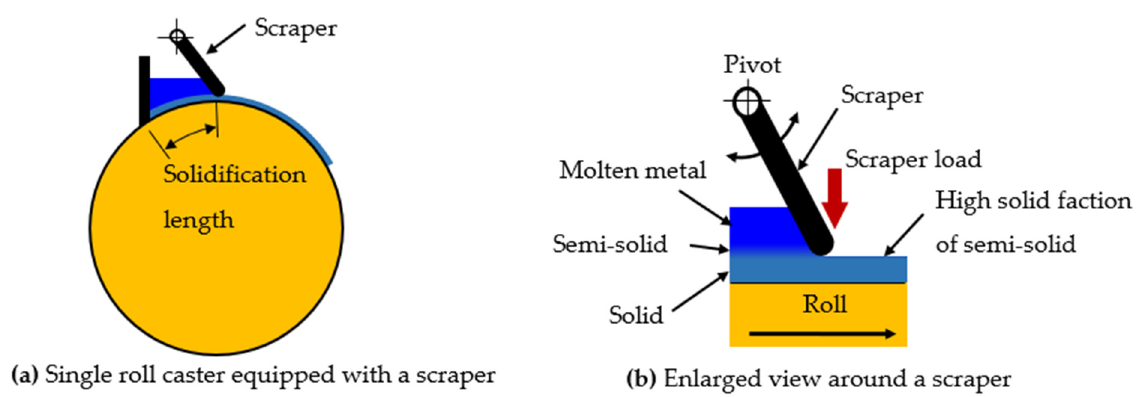
Figure 20. Schematic illustration of single-roll caster equipped with a scraper and an enlarged view of the area around the scraper.